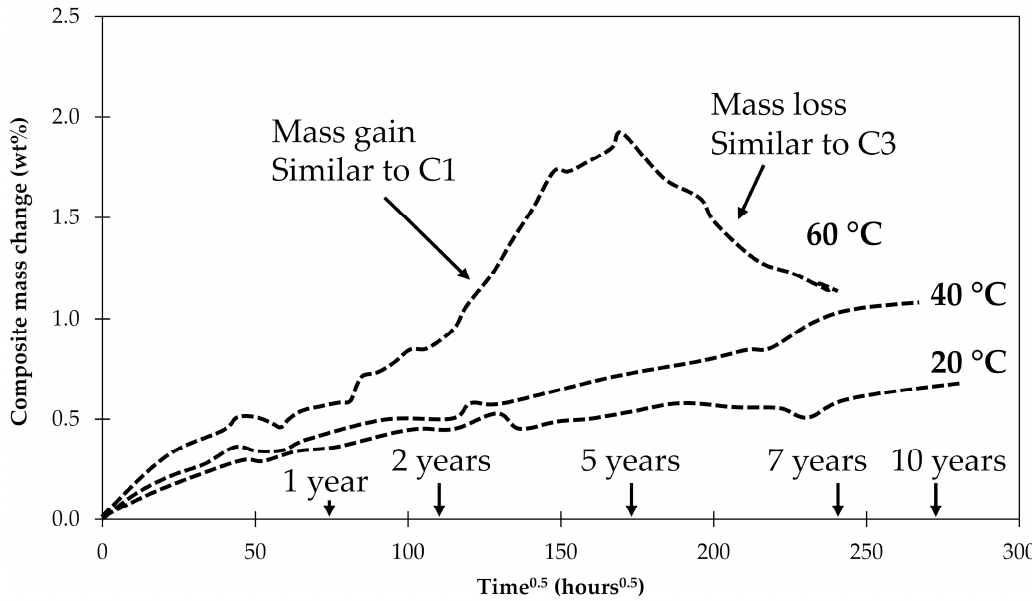
Figure 12. Schematic representation of the long-term water uptake at 20, 40 and 60 °C observed by Perreux, Choqueuse and Davies for the 2.7 mm thick composite plates